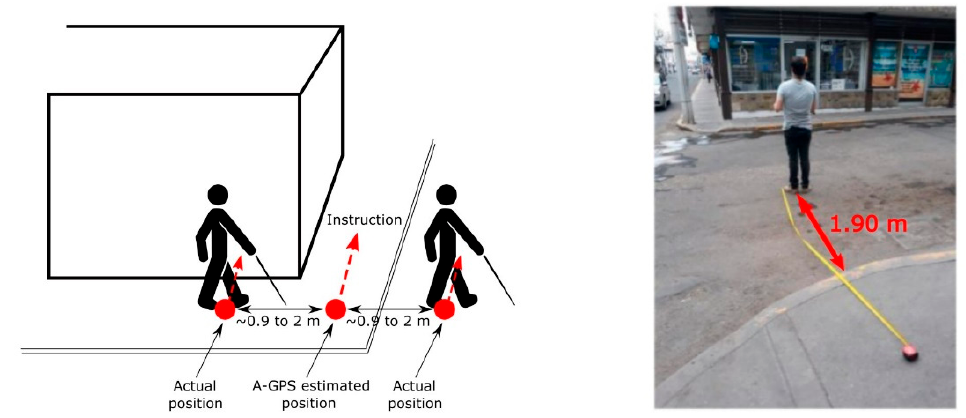
Figure 7. Positioning accuracy: ( left ) A-GPS enables accuracies in the range 0.9 to 2 m. ( right ) Due to this range, a navigational instruction might be displayed in the middle of the street.